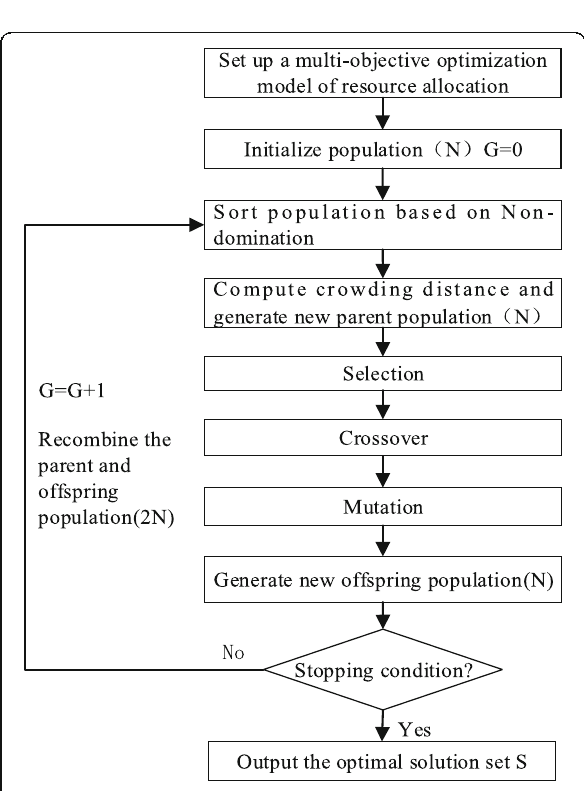
Fig. 2 The process of NSGA-II